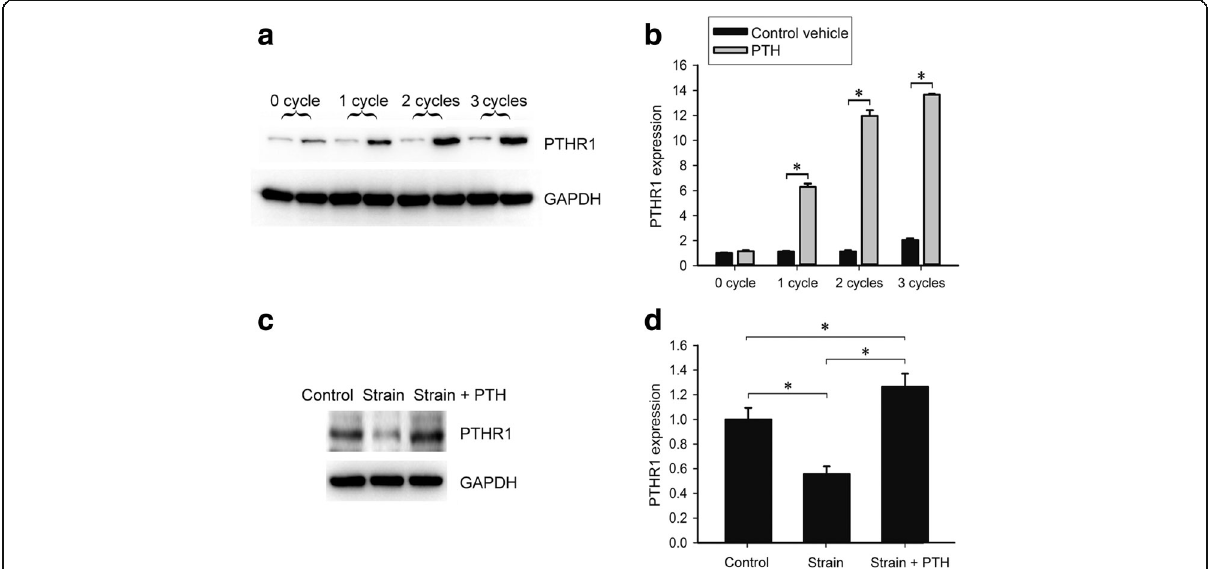
Fig. 1 Intermittent PTH treatment and mechanical strain affected the protein level of PTHR1 in OCCM-30 cells. a PTH-cycle dependent changes in PTHR1 expression detected by western blot. In each cycle, for the first 6 h, the control group was treated with vehicle culture medium containing acetic acid, and the PTH group received PTH treatment. Then they were both cultured in fresh medium without acetic acid or PTH for 18 h. GAPDH was used as a loading control. b Densitometry of bands was performed and normalized to GAPDH. c Western blot analysis of PTHR1 and GAPDH levels in OCCM-30 cells in the presence of mechanical strain and intermittent PTH. The Strain+PTH group represented cells that accepted 18 h mechanical strain, followed by 3 cycles of intermittent PTH treatment. The strain group cells were treated with 18 h mechanical strain, followed by 3 cycles of vehicle culture medium. There was neither mechanical strain nor intermittent PTH treatment in the control group. GAPDH was used as an endogenous reference. The experiment was repeated 3 times and the representative result is shown. d The bands were quantified and normalized to GAPDH. The control group was set to 1. Bars represent means±SD of triplicate measurements. * p